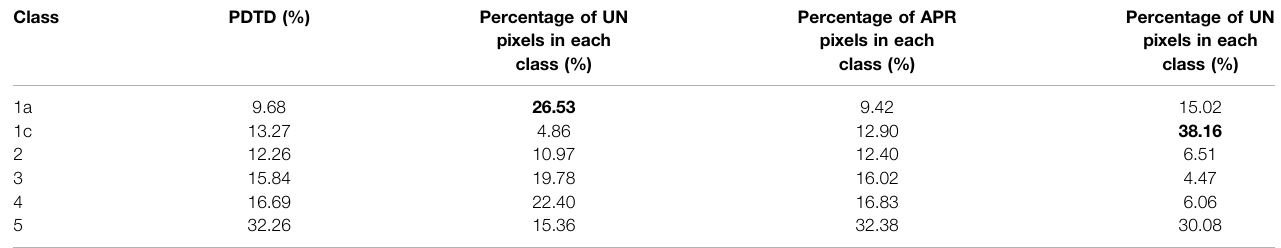
TABLE 10 | Simple statistical properties of UN/APR/OV pixel distribution across each class of the rivers factor. Class PDTD (%) Percentage of UN